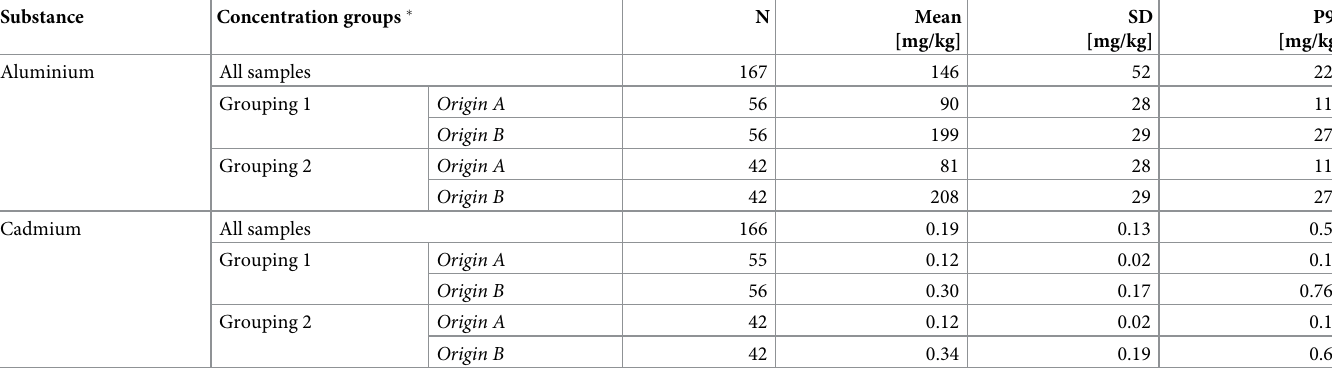
Table 3. Aluminium and cadmium concentrations in cocoa powder sampled in German Food Monitoring (GFM) 2005–2015 grouped by theoretical concentration- related geographical origins. N sample number, SD standard deviation, P95 percentile 95. All cocoa powder samples analysed for aluminium and cadmium had quantifi- able concentrations. Methods used for analysis: Graphite furnace atomic absorption spectroscopy (GFAAS) or Inductively coupled plasma mass spectrometry (ICP-MS). GFM codes: aluminium ss-1813000, cadmium ss-1848000, cocoa powder el-450401. Mean concentrations of all samples, origin A and origin B are compared. For both, alu- minium and cadmium, considering Grouping 1 and 2, there are statistically significant differences in mean substance concentrations between all samples and origin B , all samples and origin A as well as origin B and origin A according to Kruskal-Wallis test (p �